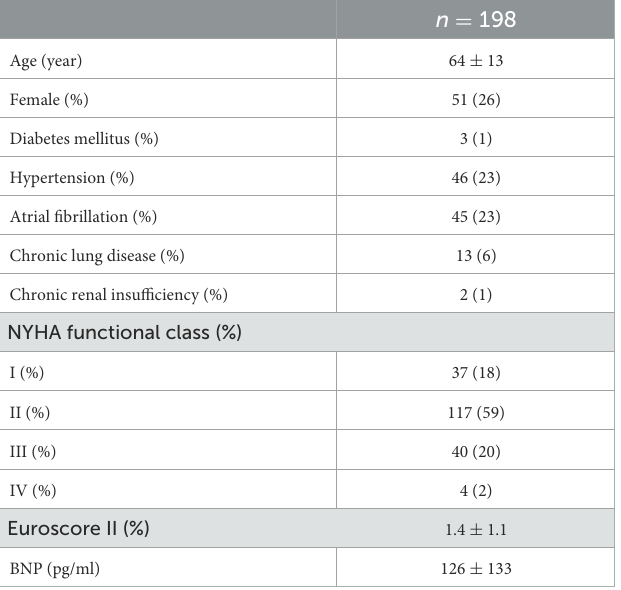
TABLE 1 Preoperative clinical characteristics of 198 patients subject to mitral valve repair for severe DMR.